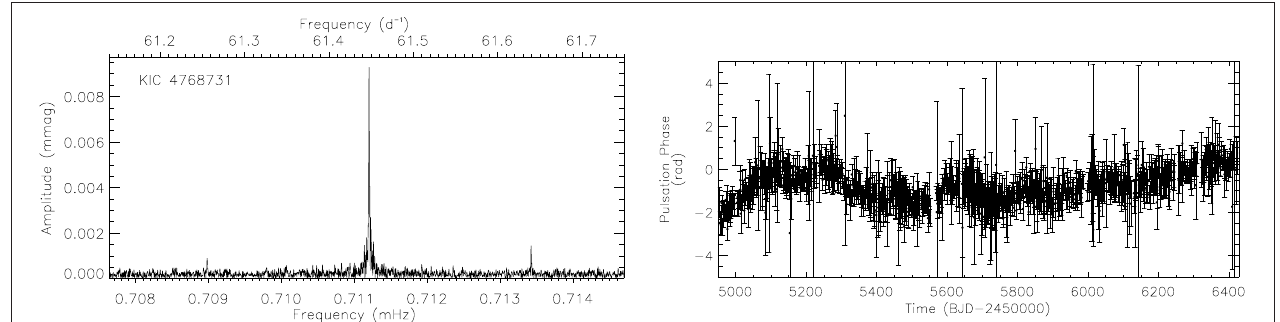
FIGURE 7 | (Left) Amplitude spectrum of the LC data for KIC4768731. The pulsation mode and two rotationally split, by 2.2218 µ Hz (5.209d), sidelobes are evident. (Right) Phase variation of the pulsation mode, showing frequency variation in this star.